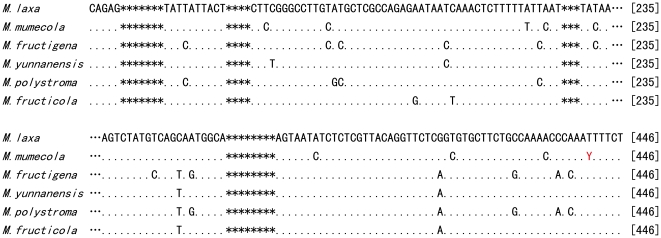
Sequence alignment of the ITS1 and ITS2 regions of ribosomal DNA (rDNA) of Monilinia spp.The sequence of M. polystroma (accession no. Y17876) was obtained from Genbank. Each Symbol ‘*’ represents conserved regions of 5 bp in length. while ‘…’ represent conserved regions of 95 bp in length. “Y” in bold indicates both cytosine(C) and thymine (T) were present in this position in M. mumecola.